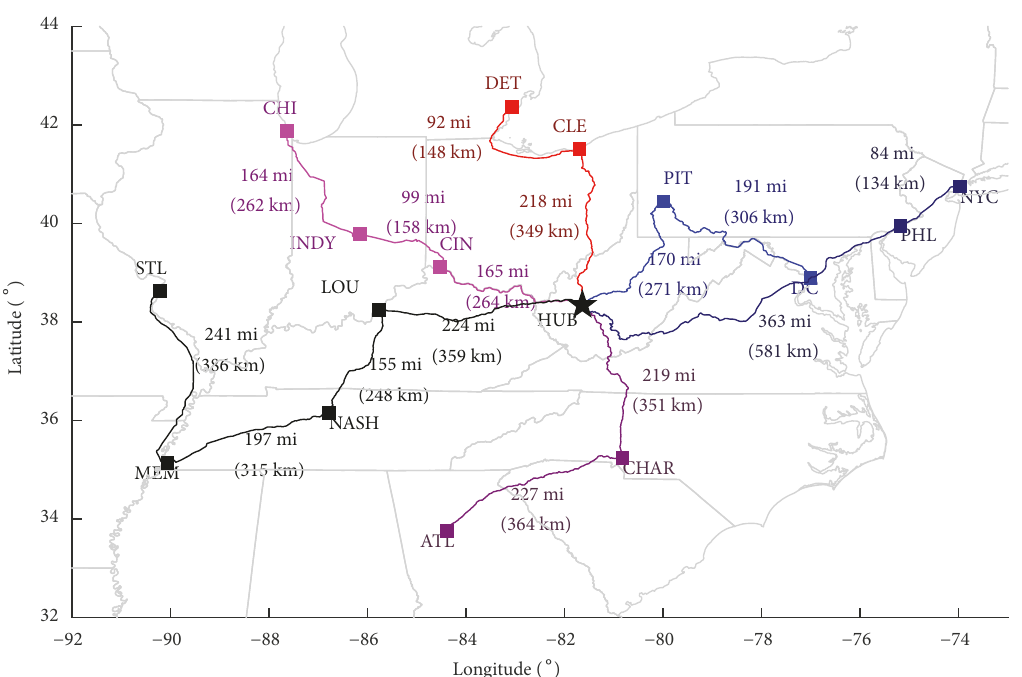
Figure 6: Solution 3: total distance = 2809.9095, iteration = 907; this solution was not selected due to the long distance of the train traveling the black line shown.